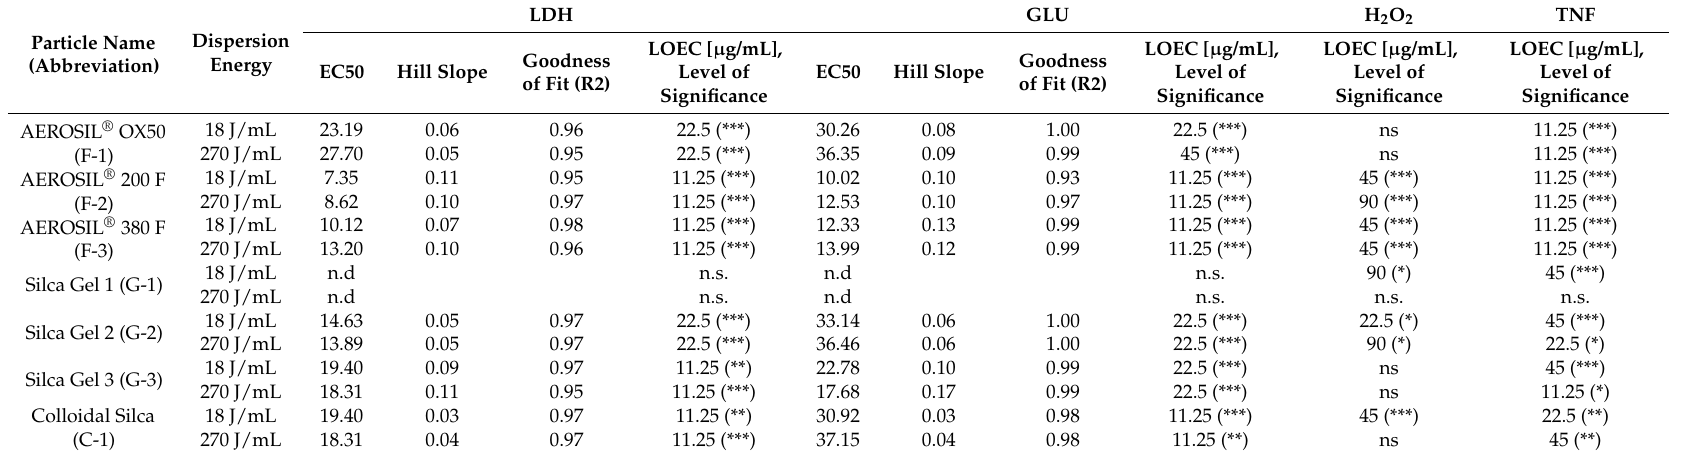
Table 6. Evaluation and curve statistics for fumed, gel and colloidal